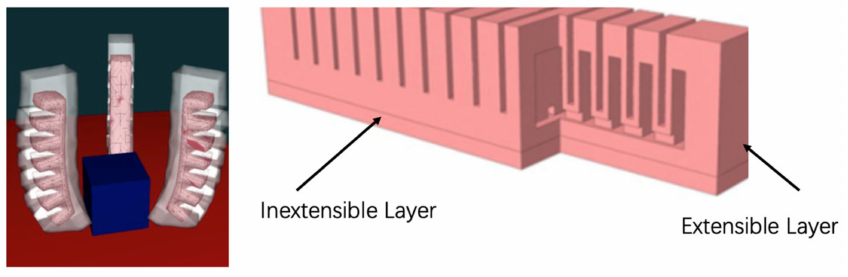
Figure 1. PneuNets structure